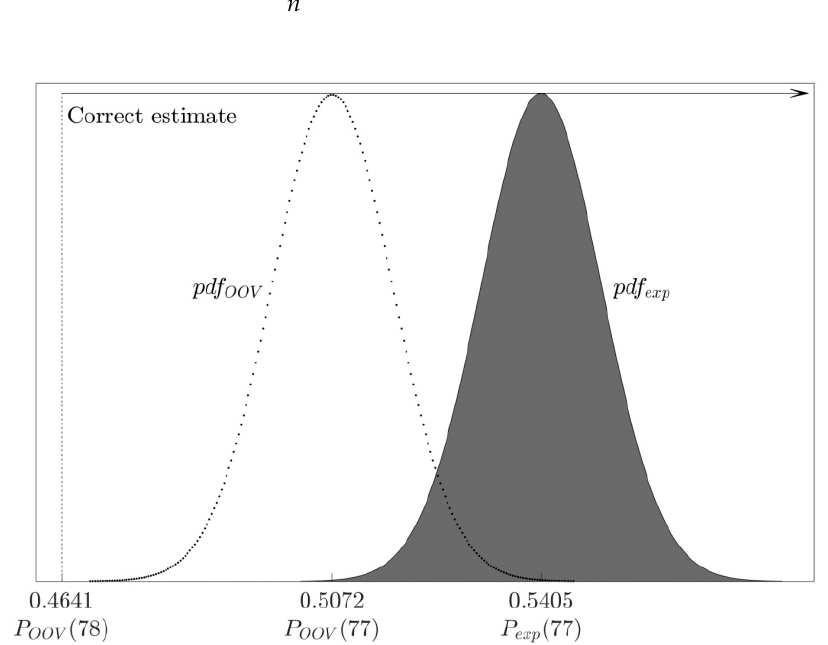
(cid:18) (cid:19) P exp ( 77 ) ( 1 − P exp ( 77 ) ) (cid:3017) (cid:3280)(cid:3299)(cid:3291) ((cid:2875)(cid:2875))(cid:4672)(cid:2869) (cid:2879) (cid:3017) (cid:3280)(cid:3299)(cid:3291) ((cid:2875)(cid:2875))(cid:4673) P exp ( 77 ) , ; (cid:4679) ; n (cid:3041) > P ( 78 ) . OOV n > (cid:3041)